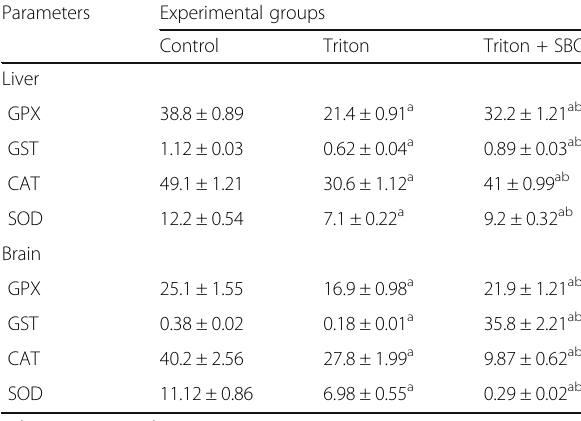
Table 1 The effect of soybean oil (SBO), Triton WR-1339, and their combination on plasma TBARS, GSH, GPx, GST, CAT, and SOD in male rats compared to a control group